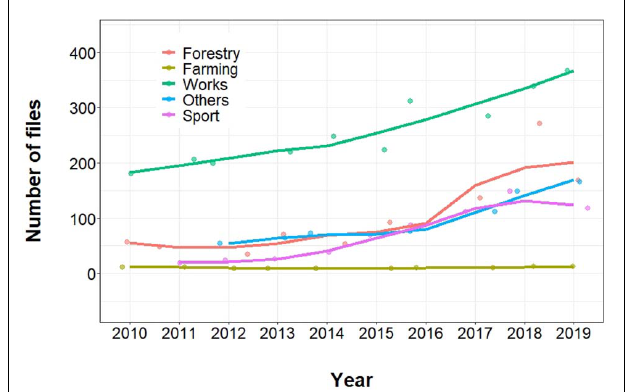
FIGURE 1 | Inter-annual variation in the number of files developed by Biscay County Council (BCC) environmental managers, where potential disturbance events on Egyptian vulture breeding areas were evaluated after the onset of the adaptative management program (2010) until 2019 (at the time of the writing, there are no available data for 2020). We considered five groups of potential disturbance events: forestry (cuts, clear-cuts, afforestation, and forest tracks; n = 1012 files); farming (activities related to habitat changes for livestock; n = 103 files); works (building or maintenance of roads, electric lines, gas pipelines, and quarries; n = 2577 files); sports (outdoor races, MTB races, and climbing; n = 639 files); and, others (new routes and tracks for climbing, walking and mountain bikes, photography projects, and game activities; n = 764 files). The lines showed the smoothed conditional means by using “loess” method in the package